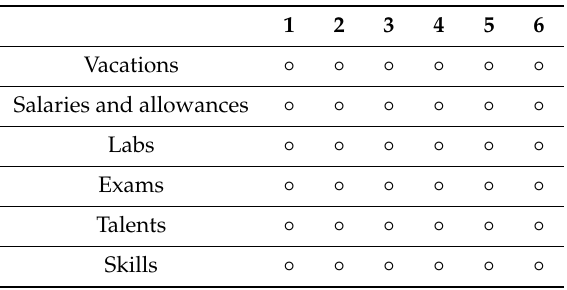
Table A2. Rank the services you use in the Faris